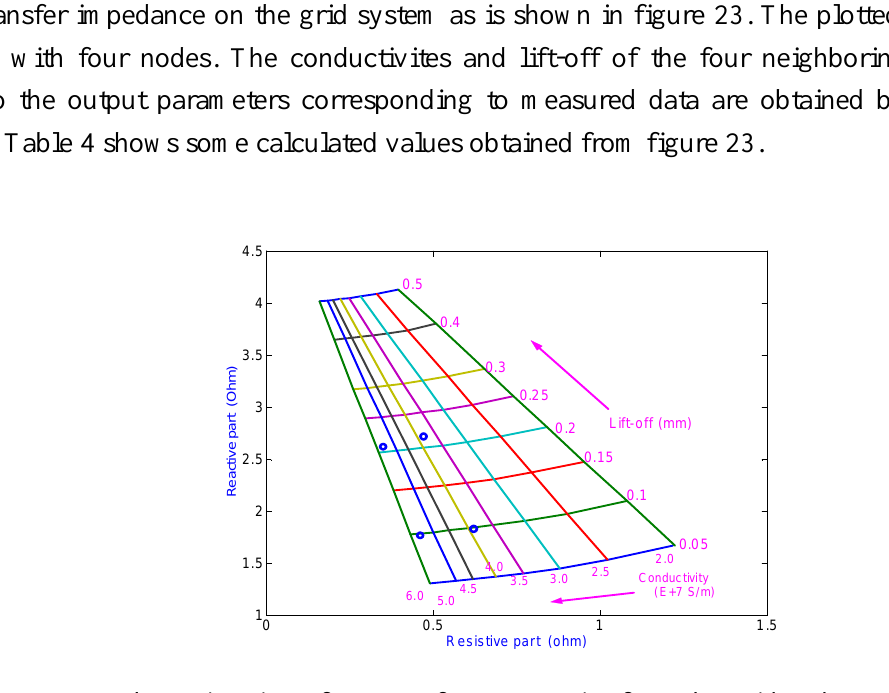
Figure 23. The estimation of near-surface properties from the grid and measured